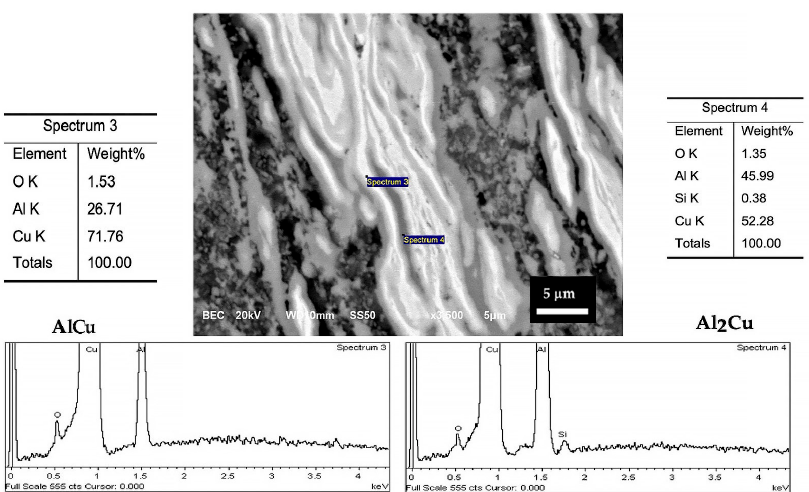
Figure 10. SEM micrographs and Energy-dispersive X-ray Spectroscopy (EDS) of AlCu and Al 2 Cu, found in weld zone of